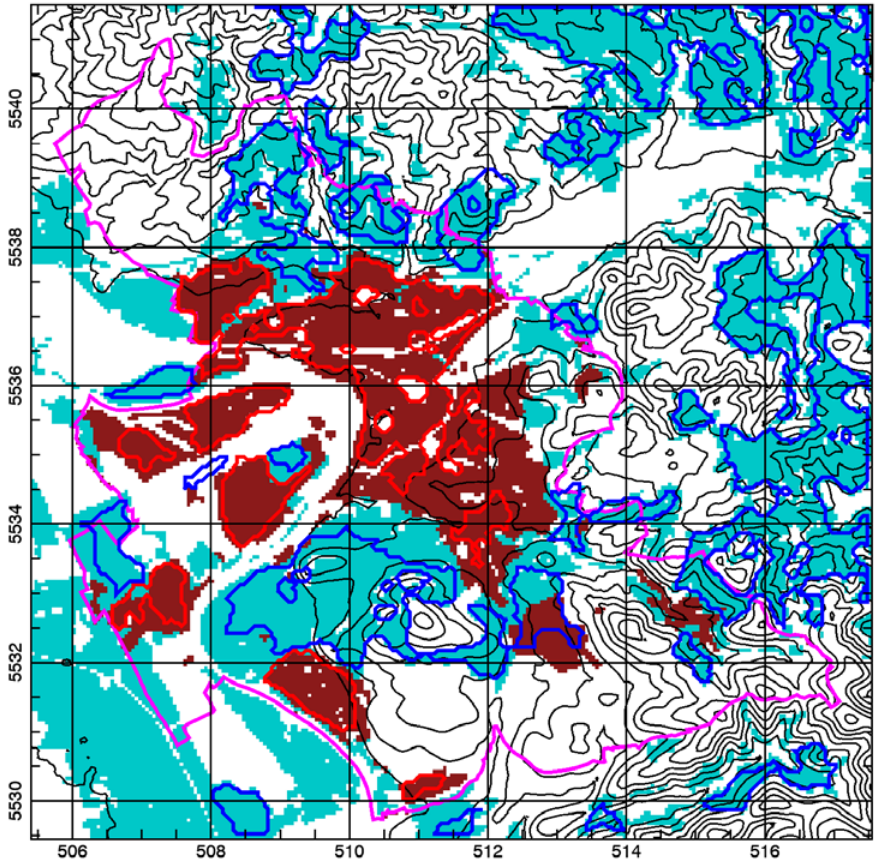
Figure 8. Map of thermal hot spots (THs, dark red areas) and cold air formation areas (CAs, cyan areas) from the land cover approach compared to the quantitative delimitation of THs (red outline) and of CAs (blue outline) in the 12 km × 12 km subdomain. Additionally, the city border of Aschaffenburg is shown as a magenta line and the terrain elevation in black contour lines.